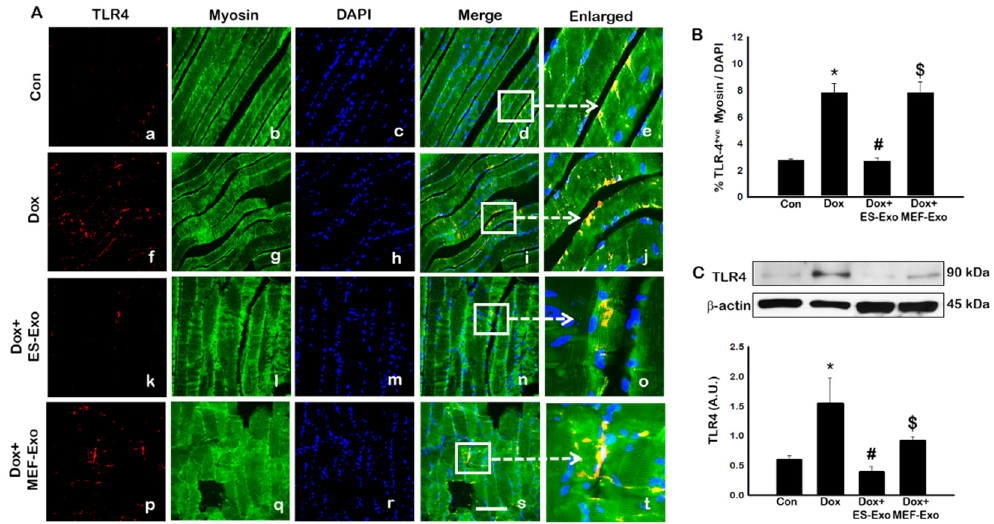
Figure 2. Treatment with ES-Exos inhibits TLR4 activation in soleus muscle. ( A ) Representative photomicrographs of soleus muscle sections stained with myosin and inflammasome marker TLR4. Each box shows TLR4 + cells in red ( a , f , k , p ), myocytes in green ( b , g , l , q ), DAPI in blue ( c , h , m , r ), merged images ( d , i , n , s ), and enlarged areas of merged images ( e , j , o , t ). ( B ) Histograms from quantitative analysis of TLR4 + cells over total DAPI. ( C ) Representative blot and densitometric analysis of TLR4. Error bars = mean ± S.E.M. * p < 0.05 vs. control, # p < 0.05 vs. Dox, $ p = non-significant vs. Dox, one-way ANOVA followed by Tukey test; western blot quantities are represented as A.U. Scale bar = 100 µm, n = 14–16, male and female ( B ) and n = 6–8, male and female ( C ). Images taken at 40 × magnification.